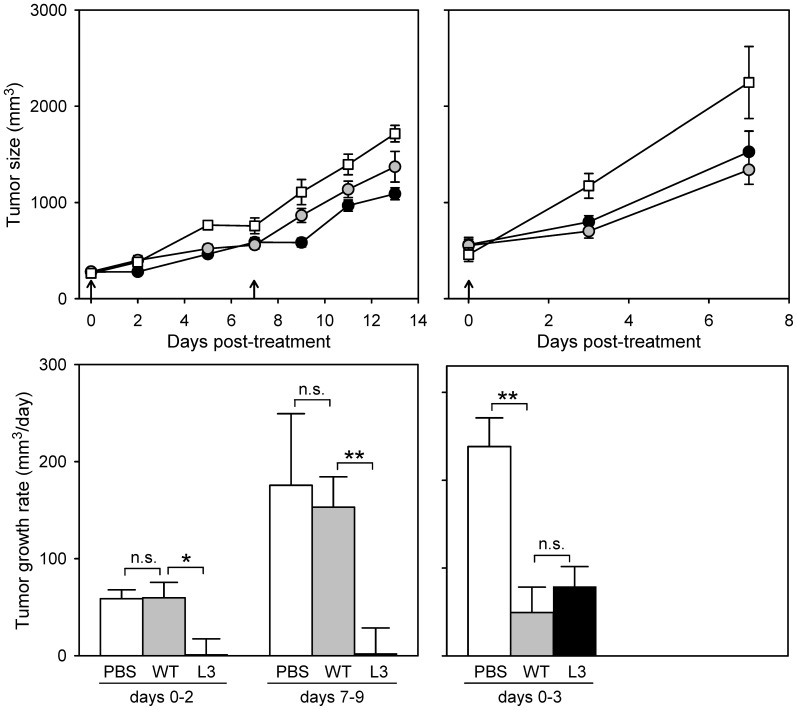
Effect of VSV L3 and WT on the growth of syngeneic Balb/c 4T1 and CT-26 tumors.Viruses were injected intratumorally 8 days (4T1) and 11 days (CT-26) after engraftment, and a second dose was administered 7 days later to 4T1-bearing mice. The experiment was terminated based on end-point criteria on days 14 (4T1) and 7 (CT-26). Top panels (a, c) show tumor growth throughout the course of the experiment for mice treated with the VSV L3 (black circles), VSV WT (grey circles) and the mock-inoculated control group (white squares). Bottom panels (b, d) indicate the tumor growth rate calculated between each viral dose and the first subsequent tumor measurement. The tumor growth rates of each group were compared using t-tests (**: P<0.01; *: P<0.05; n.s.: P>0.05). Error bars indicate the SEM.